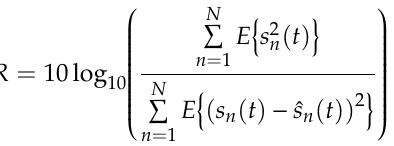
Figure 7. Performance of the support set estimation by dynamic programming.